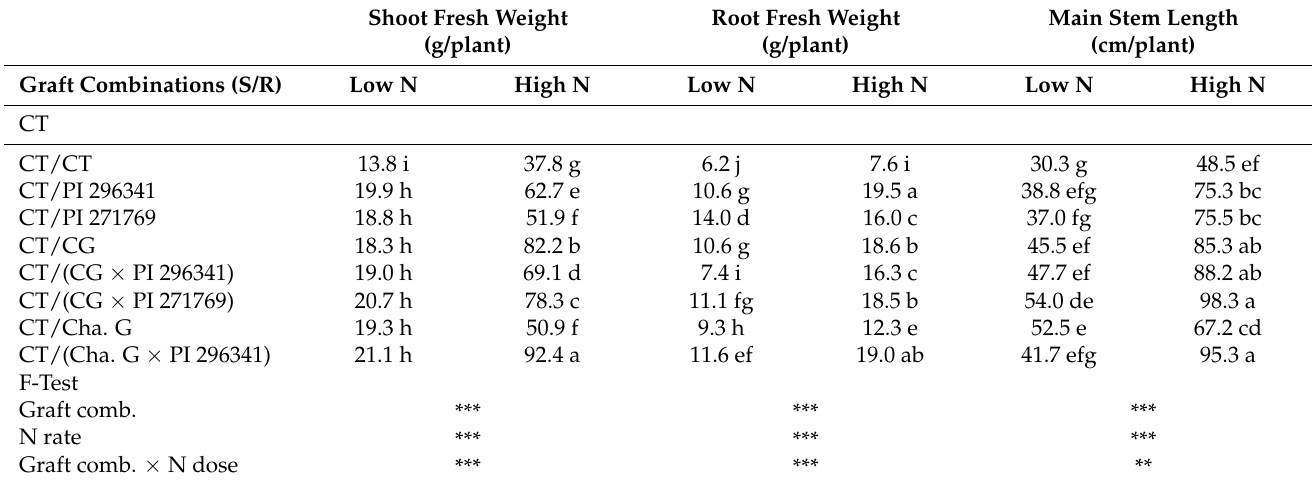
Table 1. Shoot fresh weight and root fresh weight and main stem length of self-grafted and